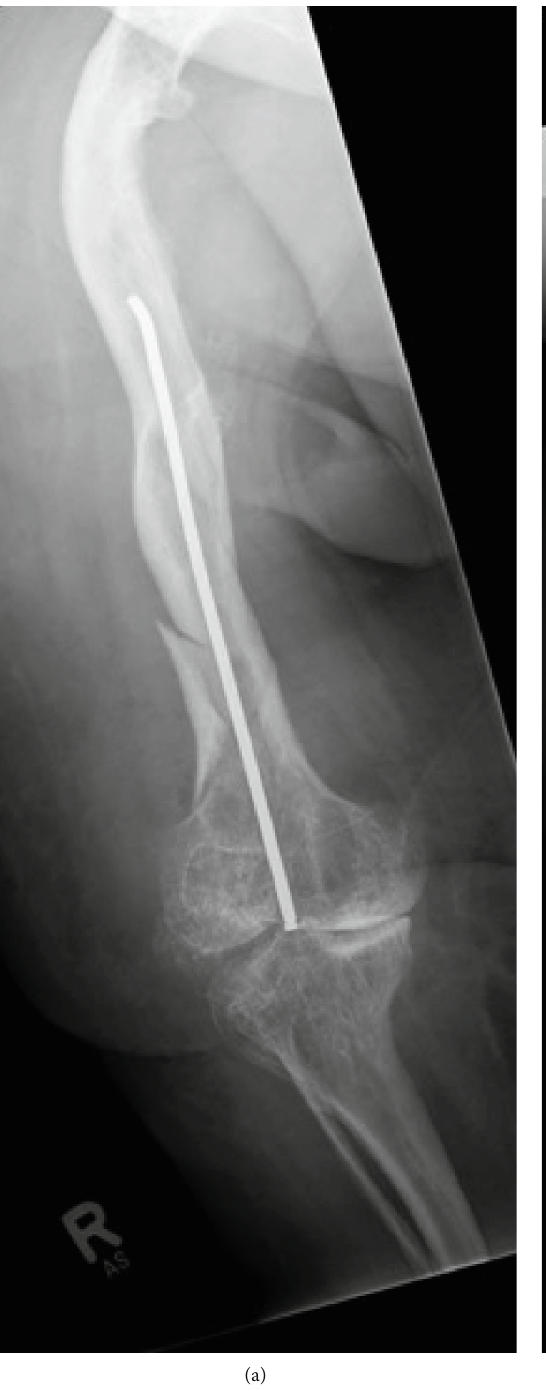
Figure 4: Postoperative radiographs from the second day after surgery. (a) Operated femur in the anteroposterior plane. (b) Corresponding lateral plane. A near-anatomical reduction of the femur has been